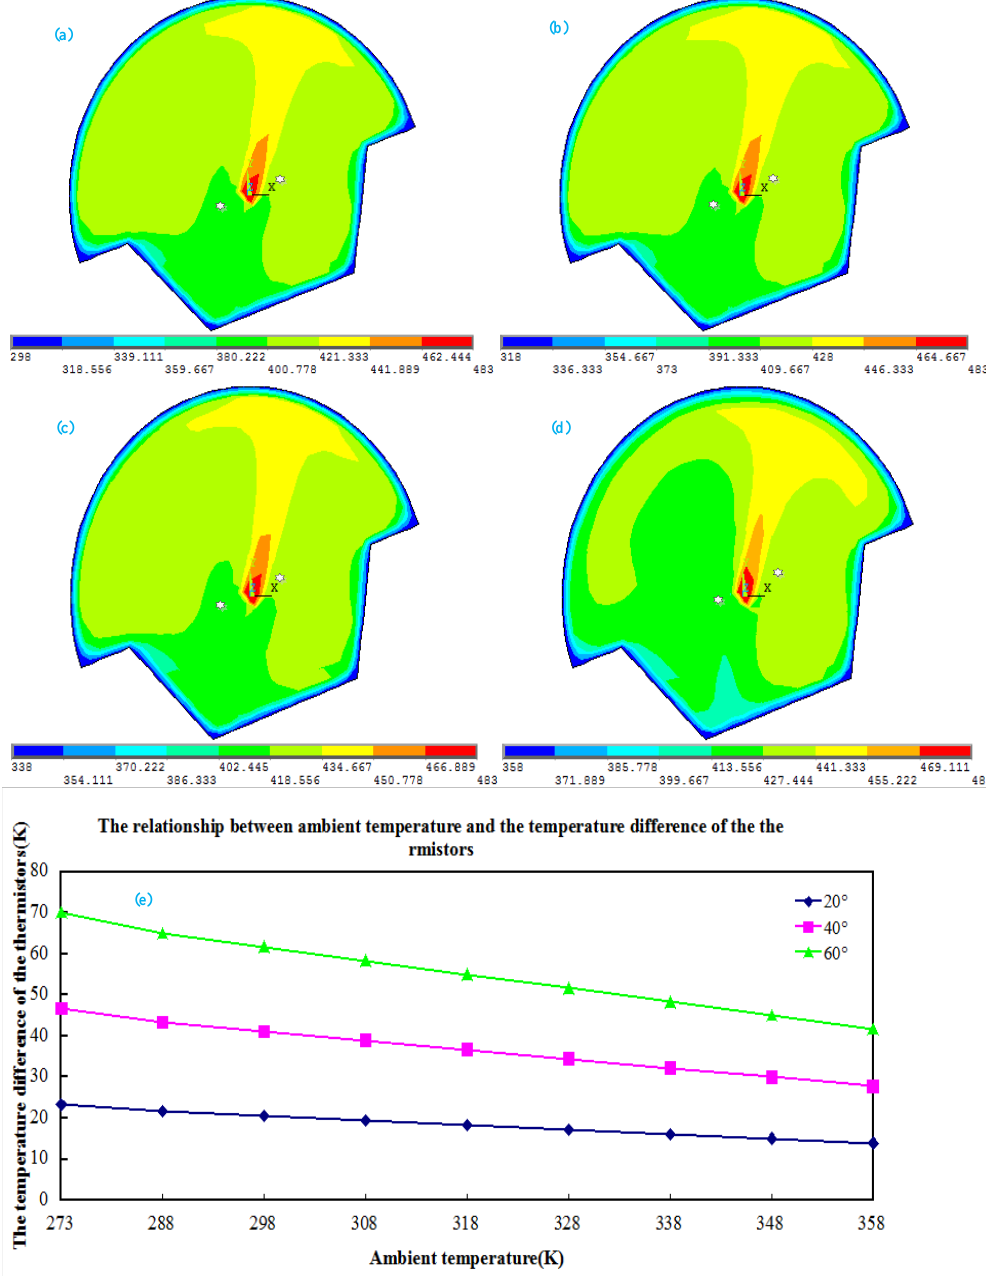
Figure 7. The simulation diagrams of temperature field within the chamber tilted a 20° angle when the ambient temperature is: ( a ) 298 K; ( b ) 318 K; ( c ) 338 K; ( d ) 358 K; ( e ) the line chart for the relationship between ambient temperature and the temperature difference of the